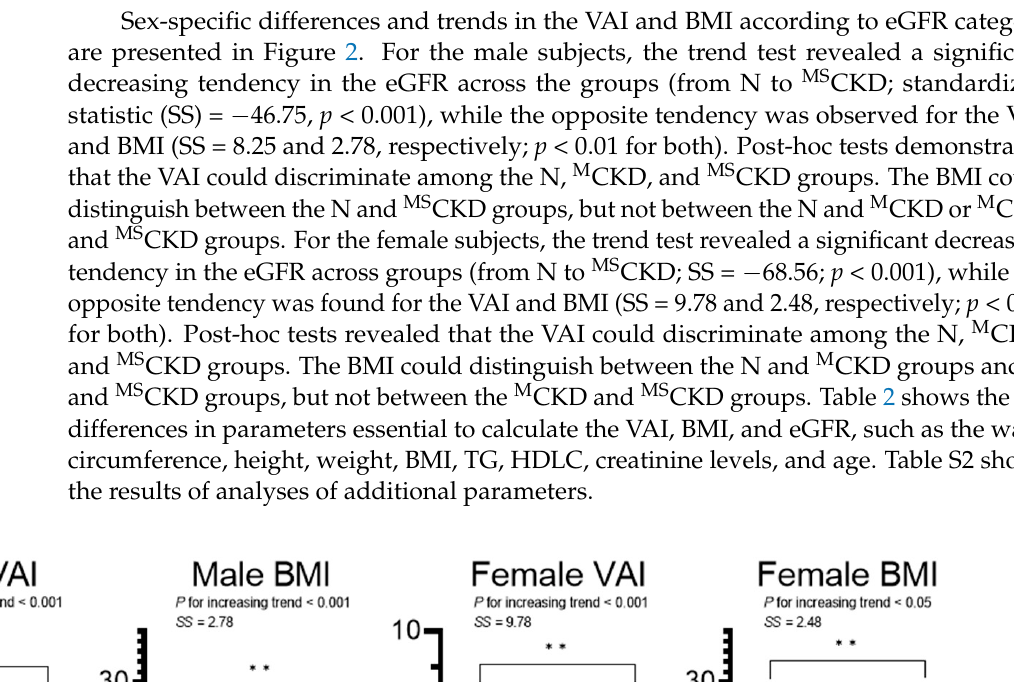
Values are means ± SD. eGFR = estimated glomerular filtration rate; HDLC = high density lipopro- tein cholesterol. † Mann–Whitney U test was applied to assess the difference between groups.